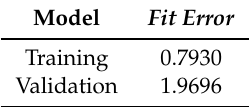
Table 1. The prediction error between the subspace based model and the process for both the training and validation